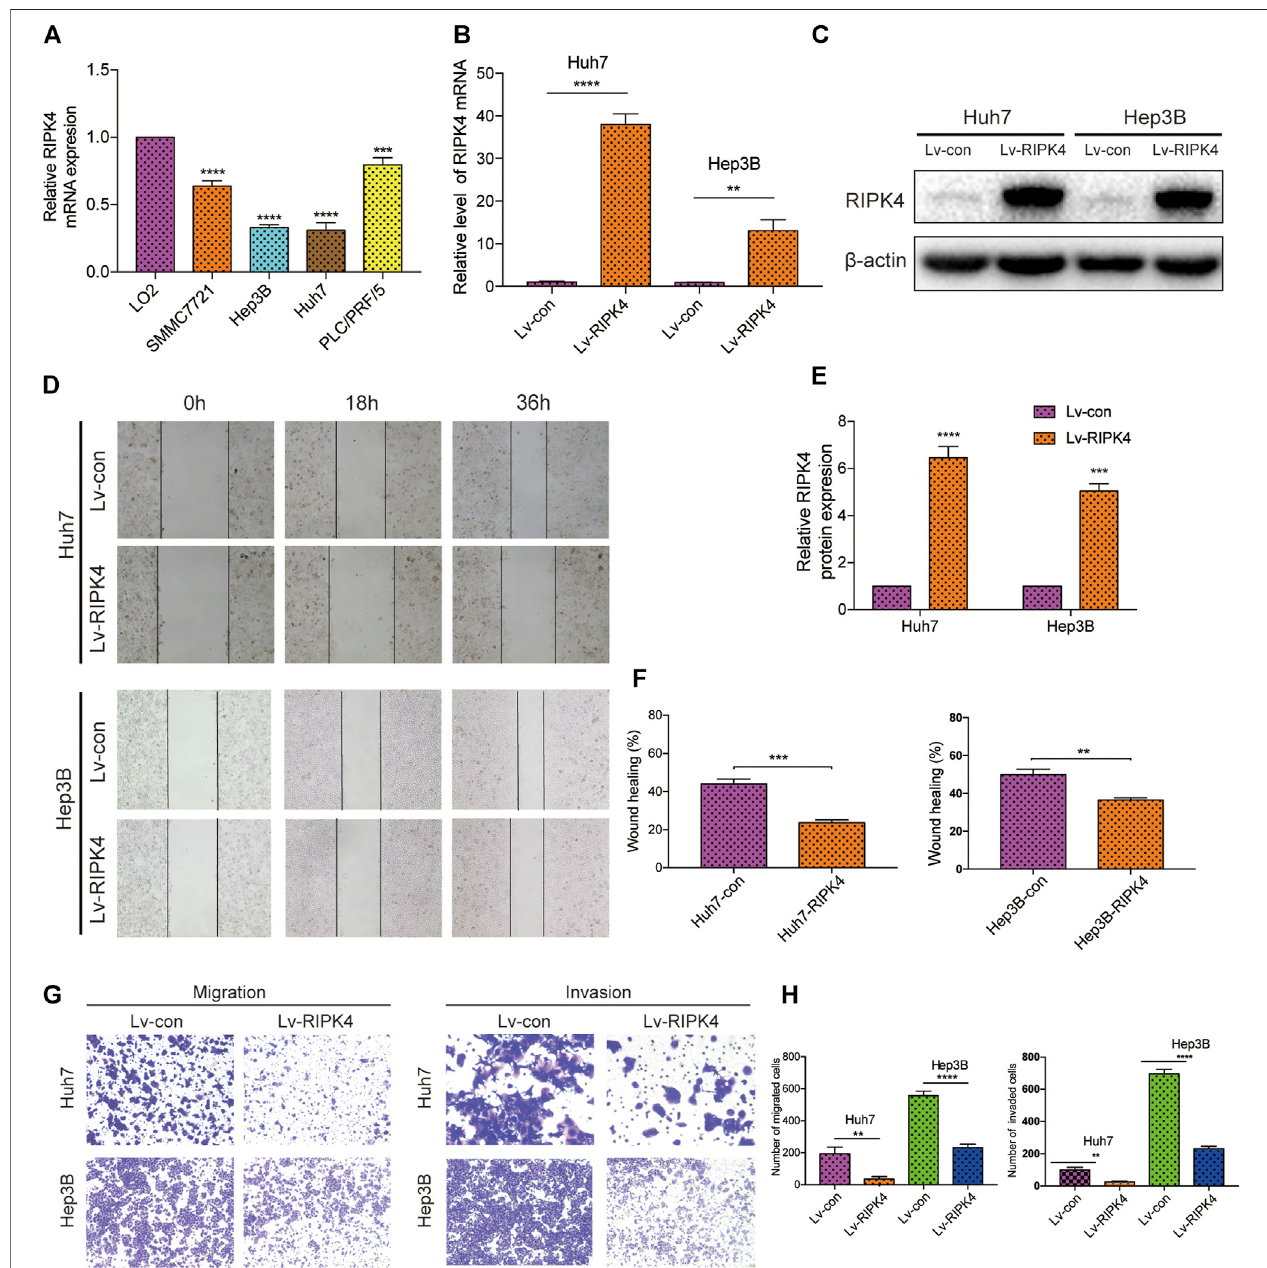
FIGURE 3 | RIPK4 inhibits the migration and invasion of HCC cells. (A) Real-time quantitative PCR analysis of RIPK4 mRNA levels in HCC cells compared to L02 cells. (B) Real-time quantitative fl uorescent PCR analysis of RIPK4 expression after lentivirus transfection. (C) Western blotting analysis of RIPK4 expression after lentivirus transfection, and ß -actin was used as a control. (D) The wound healing showed that the migrated ability of Huh7-RIPK4 and Hep3B-RIPK4 cells was decreased. (E) Statistical analysis of three independent data of western blotting experiments. (F) Statistical analysis of three independent data of wound healing experiments. (G) Representative images (100 times) of Huh7 and Hep3B cell line Transwell migration and Matrigel invasion experiments. (H) Statistical analysis on three independent data of Transwell experiment. All experiments were performed three times independently, and the data are expressed as mean ± SD. ** p < 0.01; *** p <